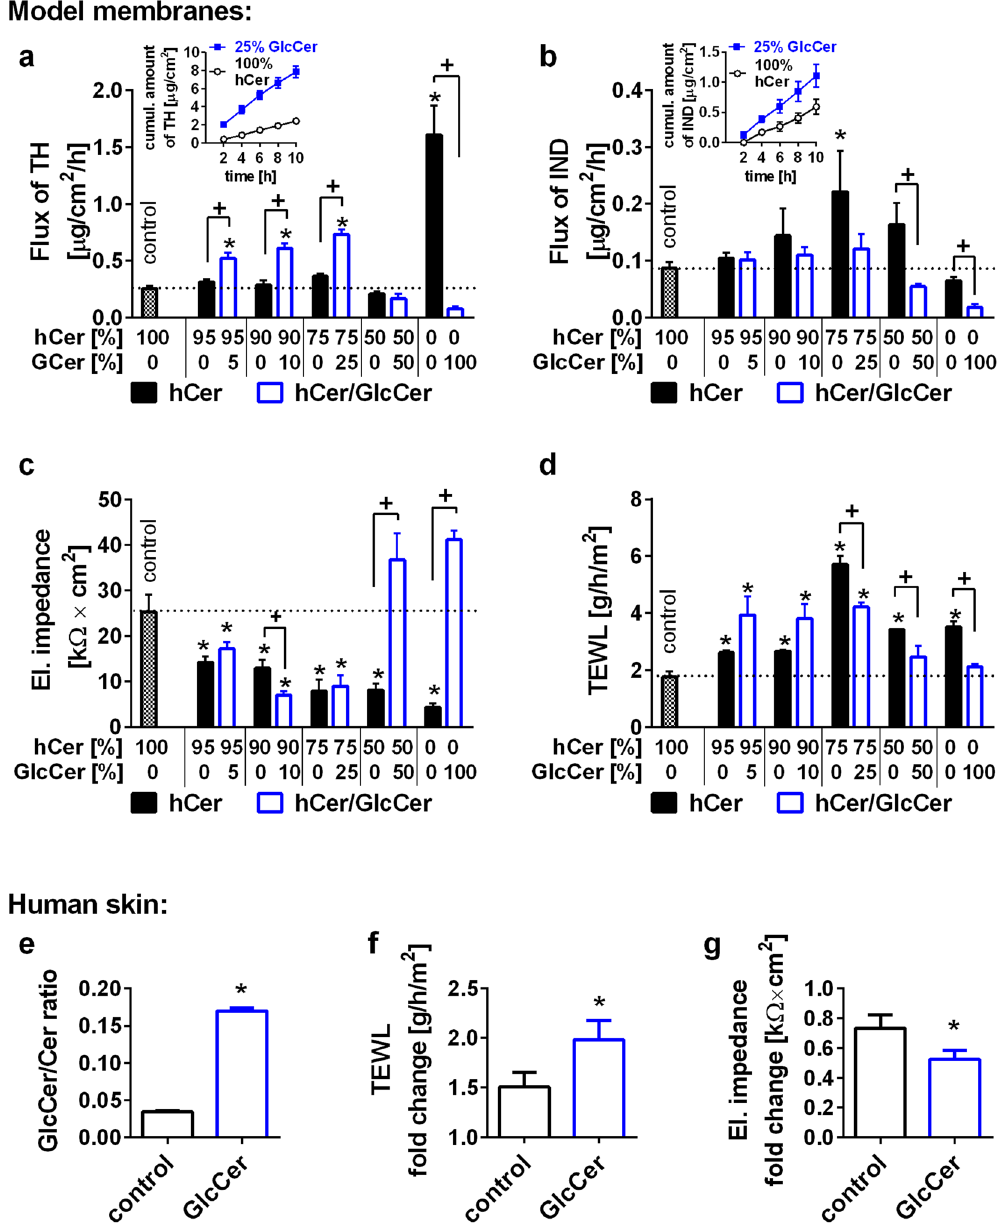
Figure 2. Permeabilities of the hCer Membrane Models ( a – d ) and Effects of Topical GlcCer on the Human Skin Barrier ( e–g ). Control membranes contained hCer/FFA/Chol/CholS; the disease models simulated accumulated GlcCer (blue) and/or diminished hCer (black) as indicated by the x-axes (molar %). The membrane permeabilities were studied using the flux of theophylline (TH; a ) and indomethacin (IND; b ), the electrical impedance ( c ) and the water loss (TEWL; d ). The inserts in ( a , b ) show examples of the permeation profiles. Panel e shows the increase in the GlcCer/Cer ratio in the human SC after topical GlcCer application; panels f-g give the fold change in the TEWL and electrical impedance, respectively, induced by topical GlcCer or vehicle (control). Mean ± SEM, n = 4 ( a – d ) or 6 ( e , f ). * Significant difference compared with control at p < 0.05; + Significant difference between the membranes with and without GlcCer at p <